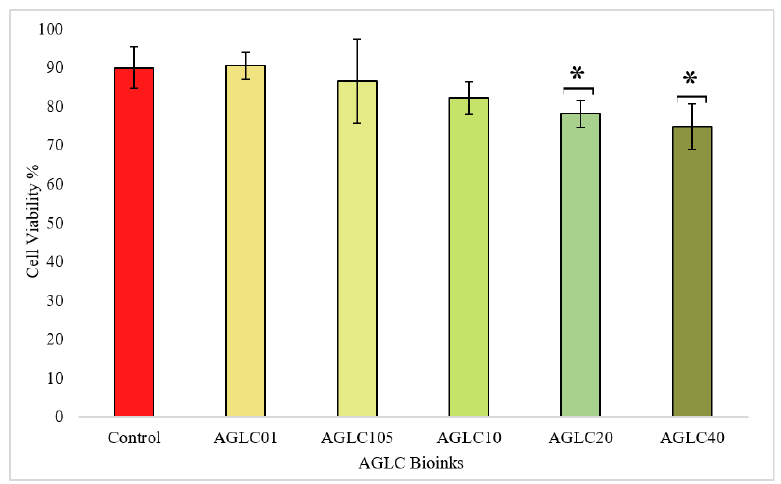
Figure 11. Cell viability % of HeLa cells after incubation with AGLC bioinks for 24 h compared with the control (n = 3, * p < 0.05). Cell viability results indicated that the AGLC bioinks showed cytocompatibility with